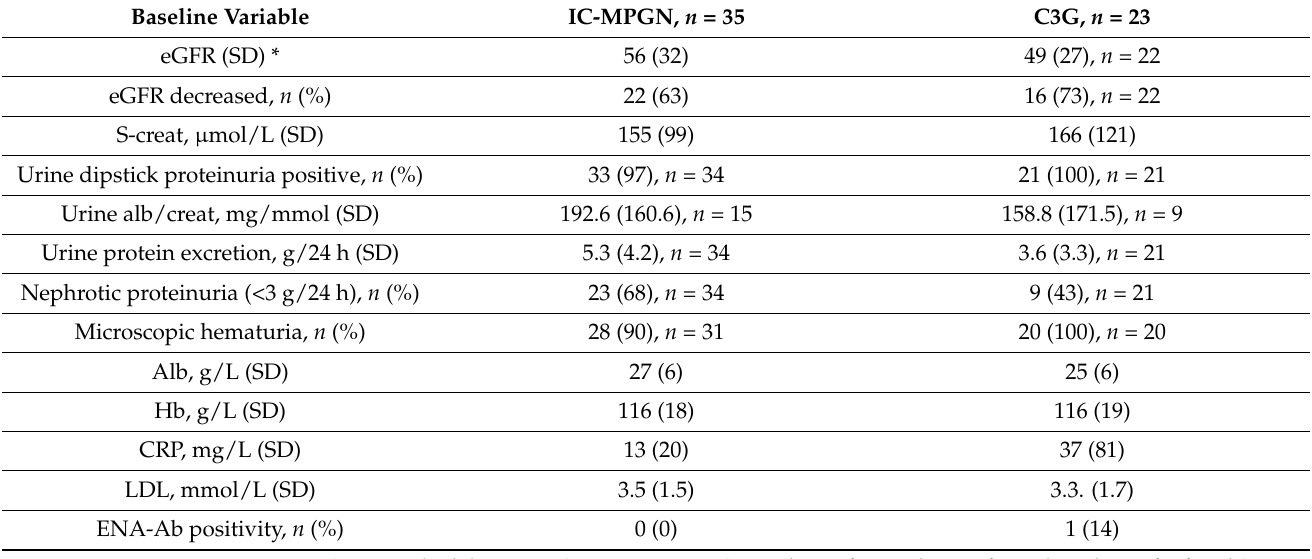
Table 2. Renal function and laboratory variables at baseline. Values are expressed as means (SD) or numbers (percentage) of patients. Reference values and units are given where appropriate. Number of patients signifies the maximum number of patients available with the information. If variable values were not available for all patients, it is expressed in the table. None of the differences between the groups were significant ( p > 0.05 for all